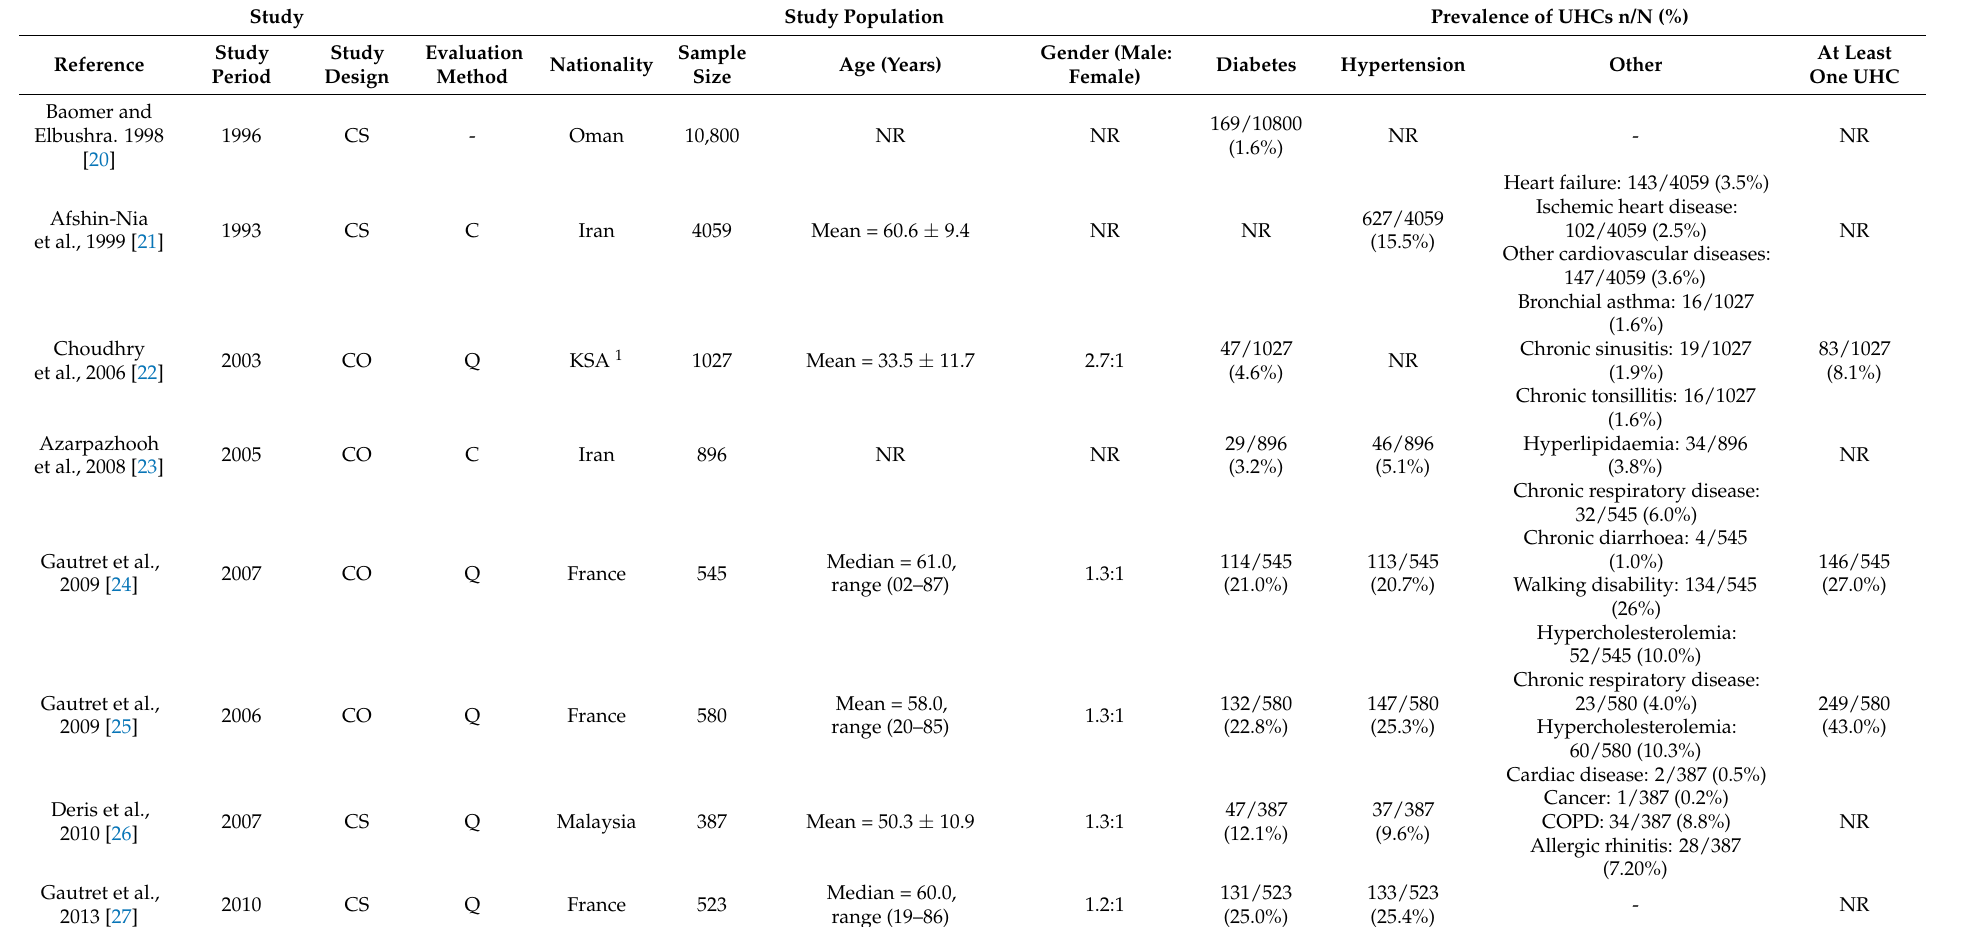
Table 1. Summary of studies reporting on the prevalence of diabetes and/or hypertension among Hajj